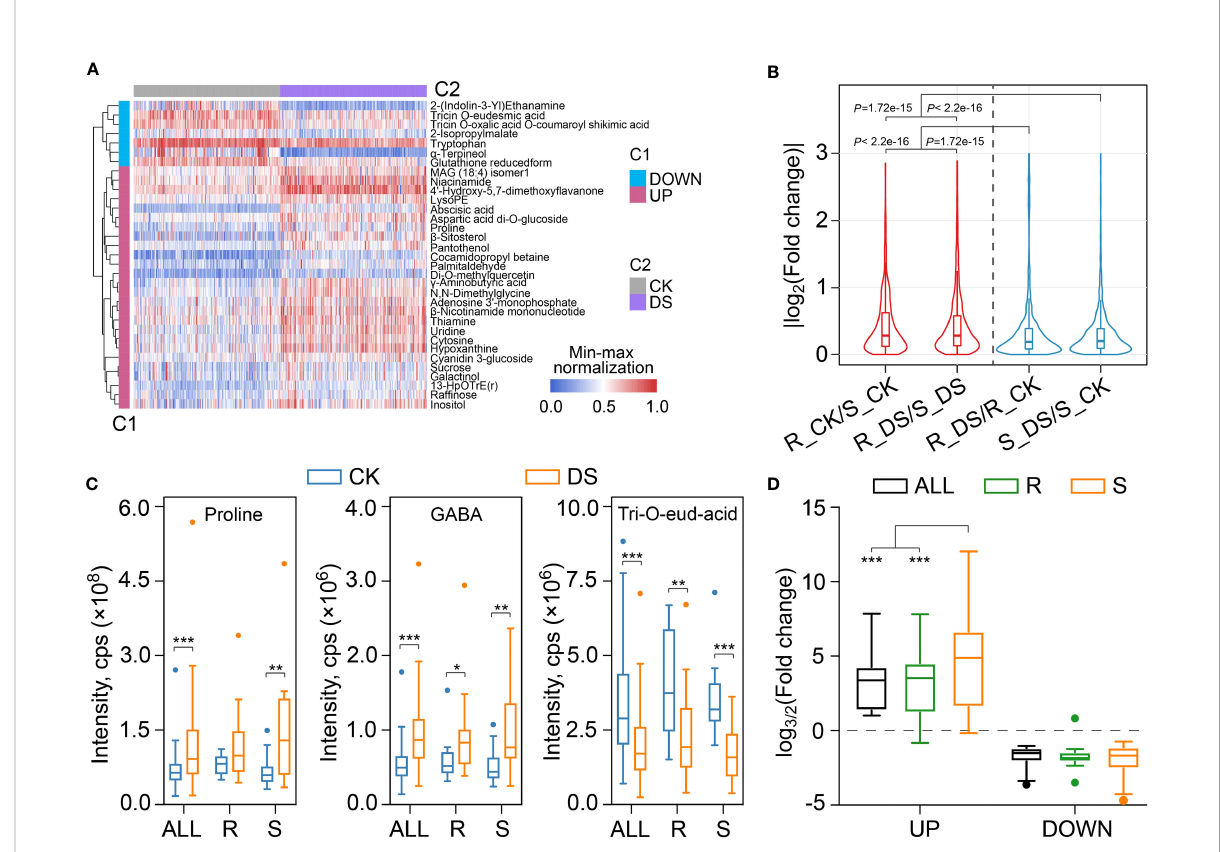
FIGURE 3 Metabolites in response to drought stress in qingke. (A) Heatmap visualization showing the metabolites accumulated differentially based on all qingke population in response to drought stress. The contents of each metabolite were normalized before performing linkage hierarchical clustering. Blue indicates the down regulated metabolites after drought stress, and red indicates the up-regulated metabolites after drought stress. (B) Violin plot showing the fold change differences between drought-resistant qingkes before and after mild drought stress (R_ DS/R_ CK), drought- sensitive qingkes before and after mild drought stress (S_ DS/S_ CK), the drought-resistant and drought-sensitive qingkes in CK condition (R_CK/S_ CK), drought-resistant and drought-sensitive qingkes after mild drought stress (R_DS/S_ DS). Red indicates the fold change of metabolites between drought-resistant and drought-sensitive qingkes under the same conditions, and blue indicates the fold change of metabolites of drought-resistant or drought-sensitive qingkes in response to drought stress. Wilcox-test P-value is also displayed. (C) The content of proline, GABA and Tricin O - eudesmic acid in all qingkes (ALL) populations, drought-resistant qingkes (R) and drought-sensitive qingkes (S) before (CK) and after (DS) drought stress. Student ’ s t-test, P-value < 0.05, marked with “ * ” P -value < 0.01, marked with “ ** ” P -value< 0.001, marked with “ *** ” . (D) The box plot shows the fold change of up-regulated and down-regulated metabolites based on all qingke populations in response to drought stress in all qingke populations (ALL, black), drought-resistant (R, green) and drought-sensitive (S, orange)